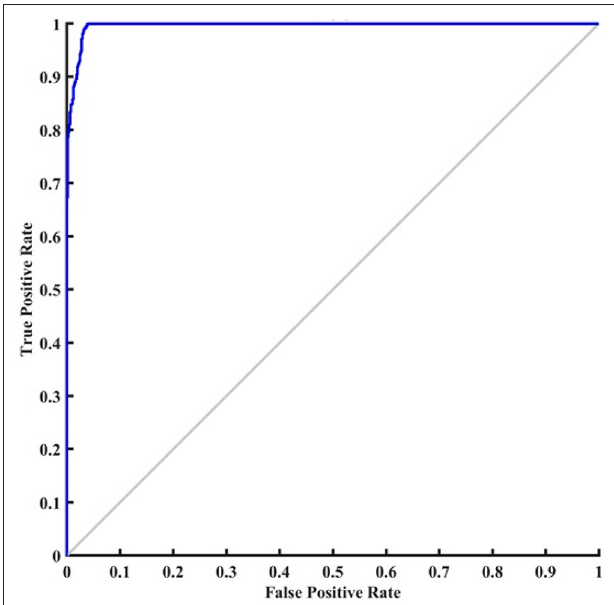
FIGURE 10 | ROC curve of the proposed system.